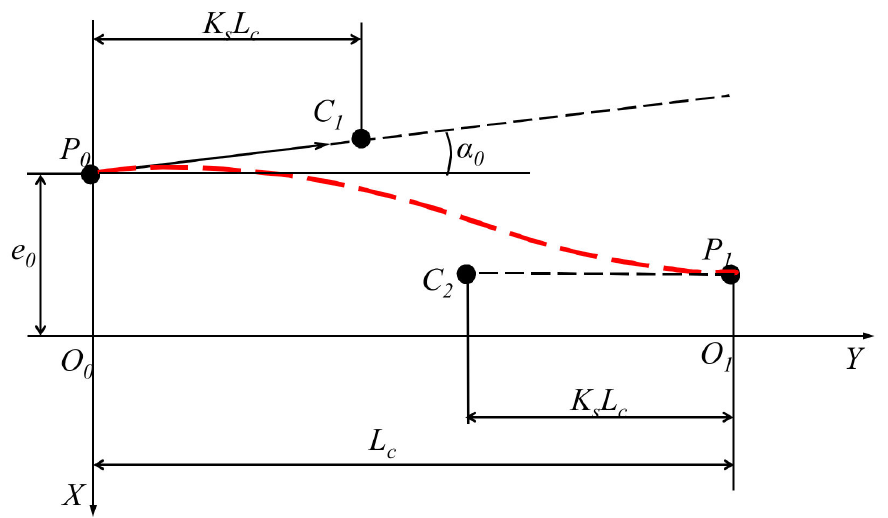
Figure 9. The planning path of the third-order Bessel curve when | e 1 | > | e 0 | and | e 0 | > [ e